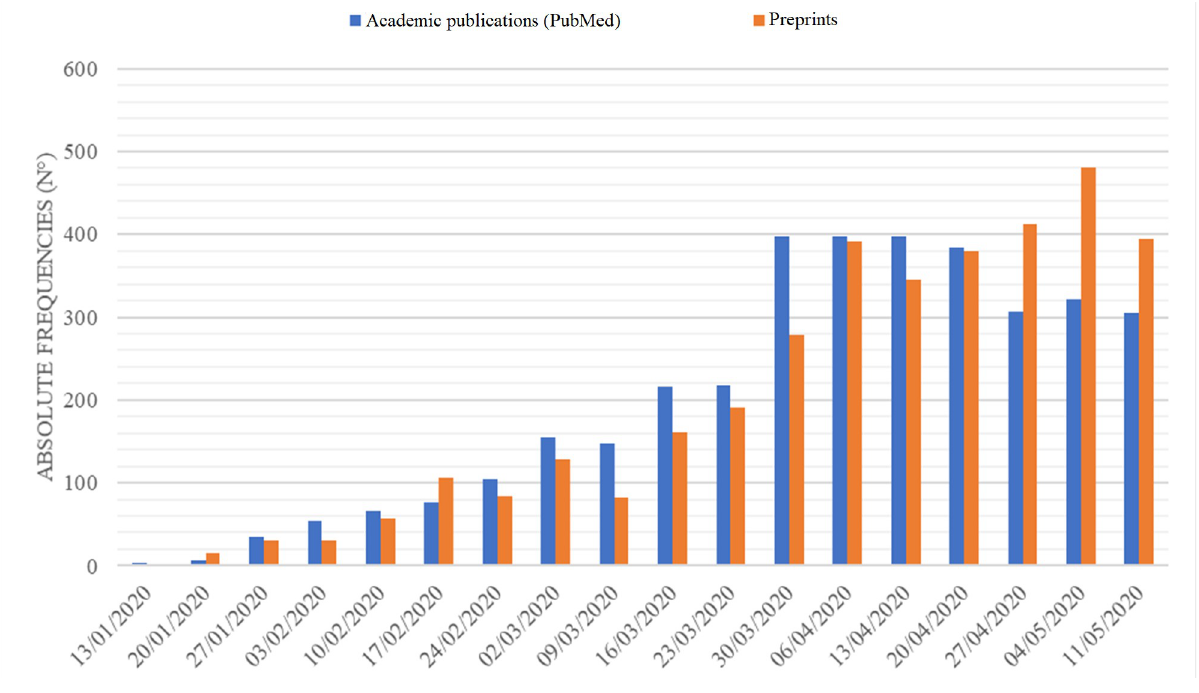
Fig 2. Absolute frequency of academic and preprint publications by week.